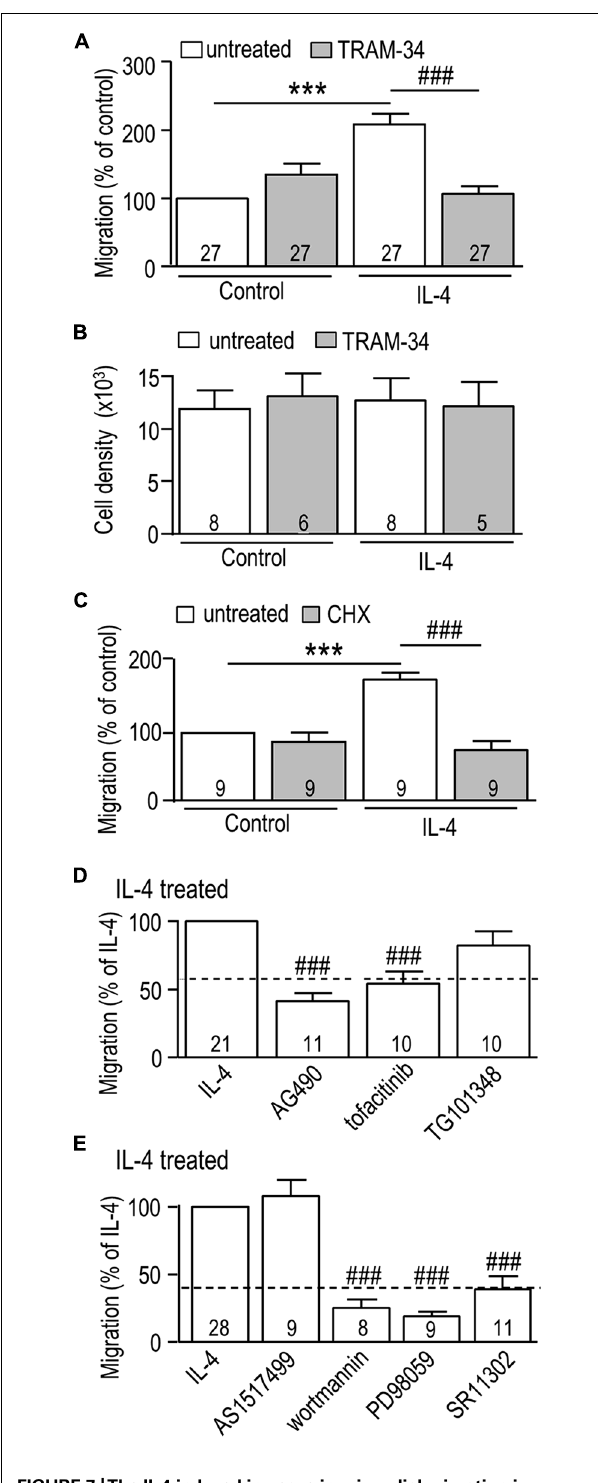
FIGURE 7 | The IL-4 induced increase in microglial migration is mediated through JAK3 and MEK signaling, and requiresAP-1 activation, new protein synthesis, and KCa3.1 channel function. (A,C–E) Rat microglia were seeded inTranswell TM chambers and left unstimulated (control cells) or treated for 24 h with 20 ng/ml rat recombinant IL-4.When used, each inhibitor was added immediately